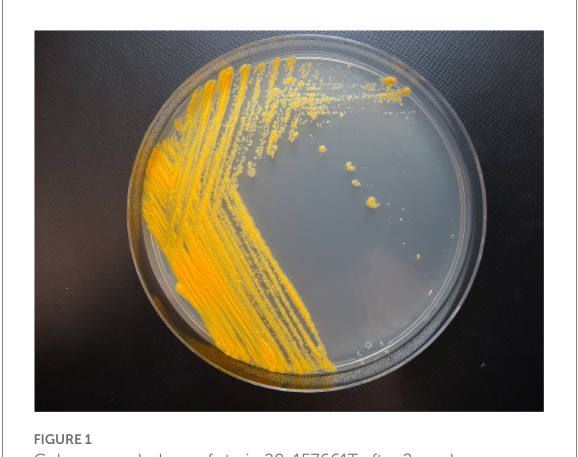
FIGURE 1 Colony morphology of strain 20-157661T after 2 weeks incubation at 37 ° C on Middlebrook 7H10 agar